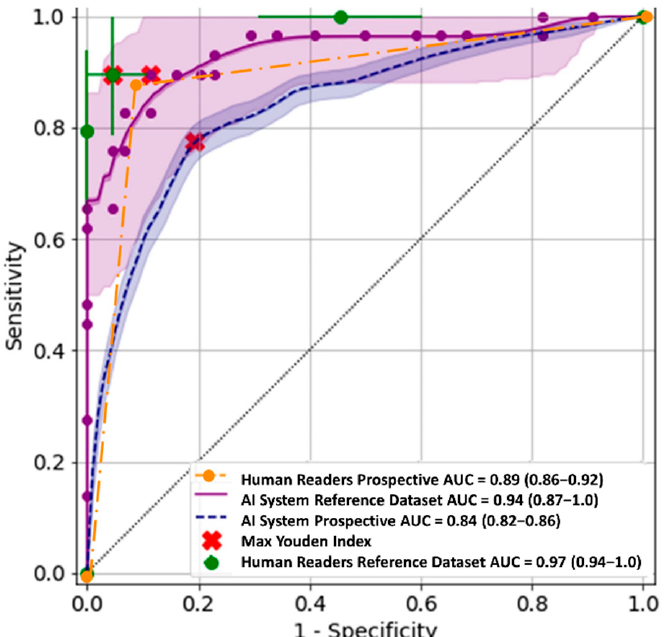
Figure 3. Receiver operator characteristic curves for multi-reader study (green) and AI performance on the local test set (purple), prospective performance of AI (blue). Receiver operator characteristic curve for radiologists on the sample from the prospective dataset for expert interpretation (yellow).